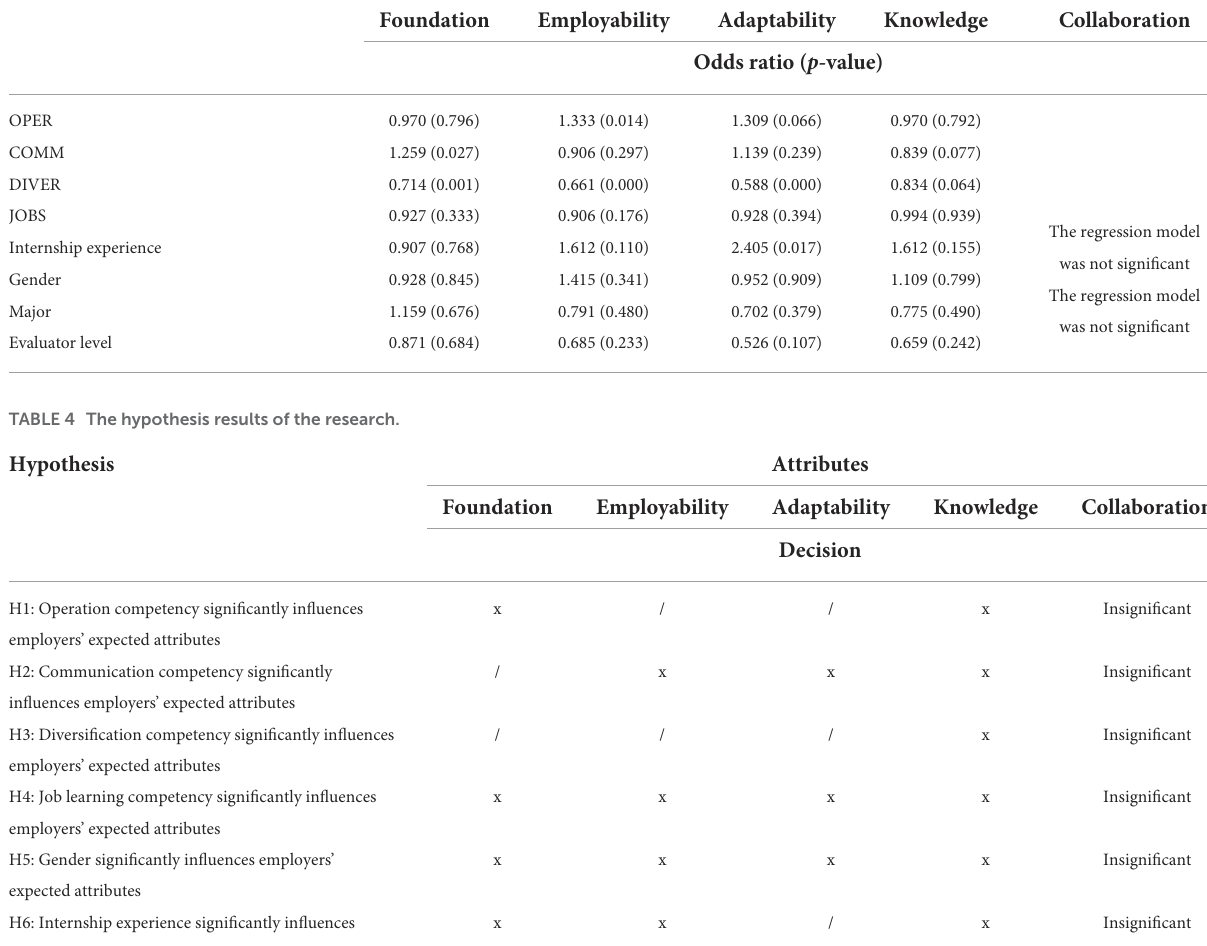
TABLE 3 Logistic regression models predicting the factors of the attributes. Independent and control variables